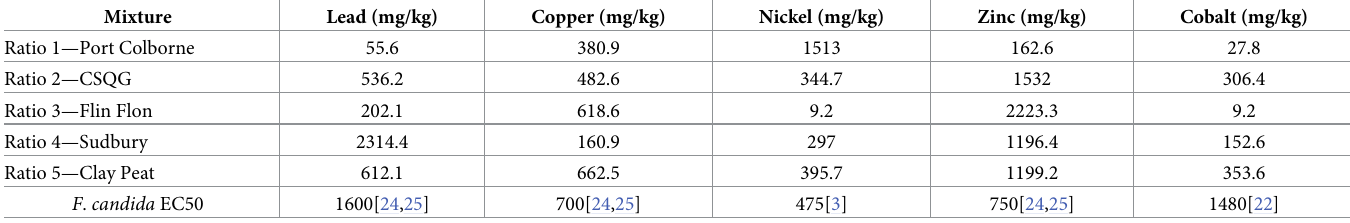
Table 2. Nominal metal mixture ratio compositions in mg kg -1 dry weight of soil at a dose of 4 toxic units and Folsomia candida EC 50 used in estimating toxic units. Mixture Lead (mg/kg) Copper (mg/kg) Nickel